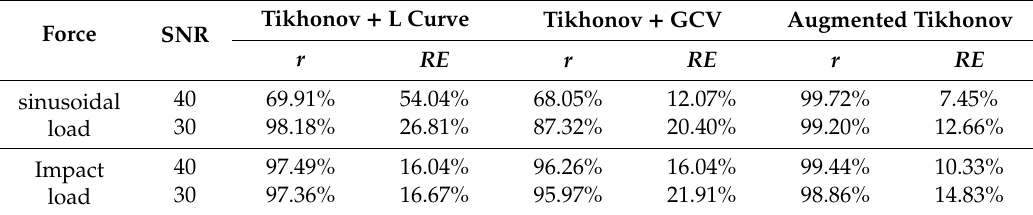
Table 4. Force identification effect of cantilever.